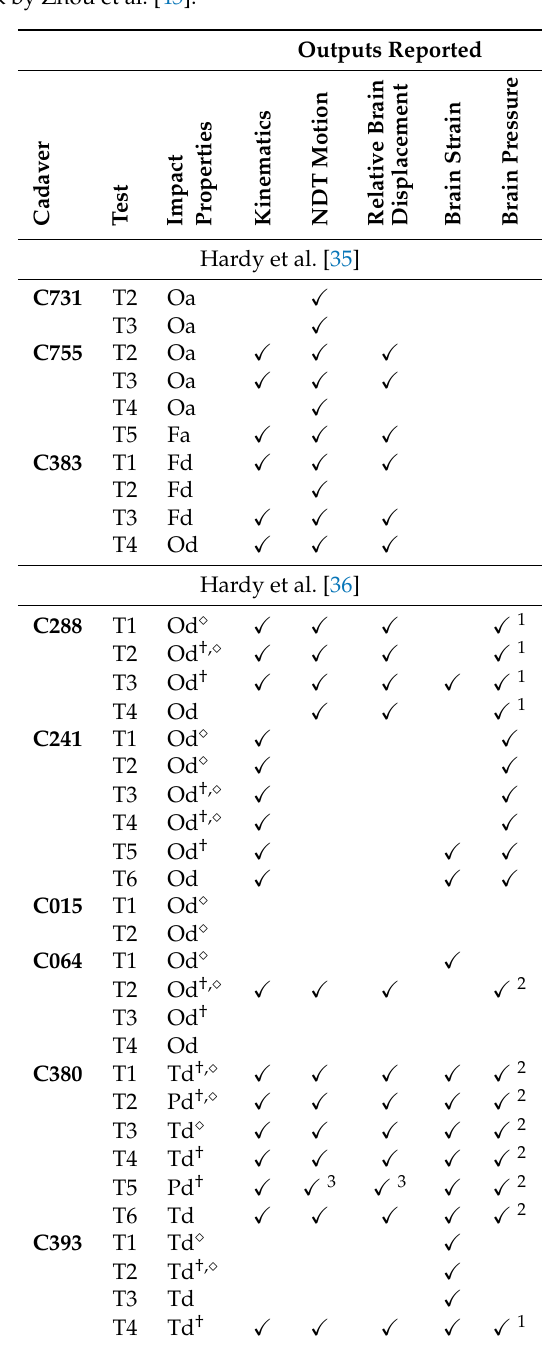
Table 3. Summary of impact properties and reported cadaver response features across experiments conducted by Hardy et al. [35,36], excluding those performed on C408 and C472 [36], which were considered unsuitably instrumented for replication in a validation environment. Data is only considered if full time-histories are published. Peak response magnitudes are more completely reported through [35,36]. Brain Strain measures marked as reported correspond only to those which were corrected in later work by Zhou et al.